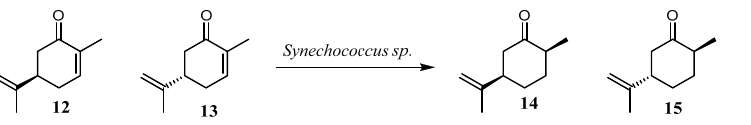
Figure 3. ( R )-( − )-carvone and ( S )-(+)-carvone reduction after 3 days of incubation by Synechococcus sp . PCC 7942 to (1 S ,4 R )- dihydrocarvone and (1 S ,4 S )-dihydrocarvone. sp. PCC 7942 to (1 S ,4 R )-dihydrocarvone and (1 S ,4 S